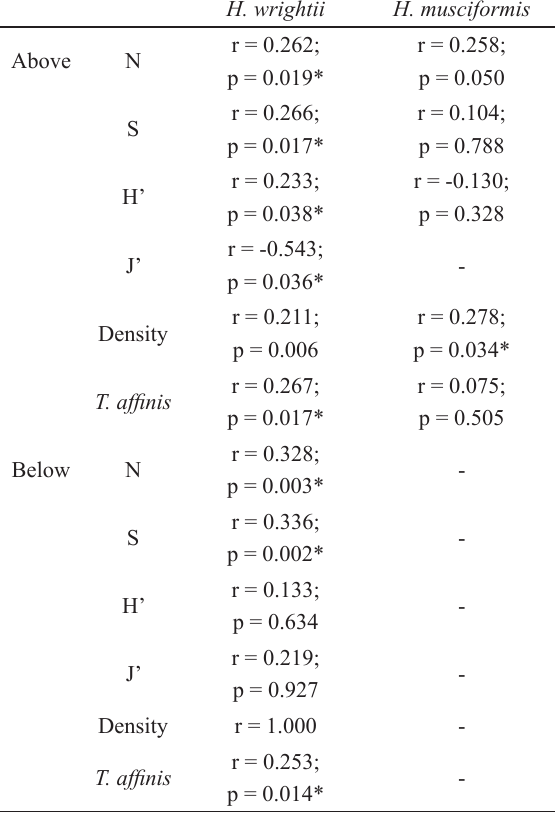
Spearman rank correlations among descriptors of the molluscan community with Halodule wrightii and Hypnea musciformis biomasses in Goiabeiras Beach, Fortaleza-Ceará, Northeastern